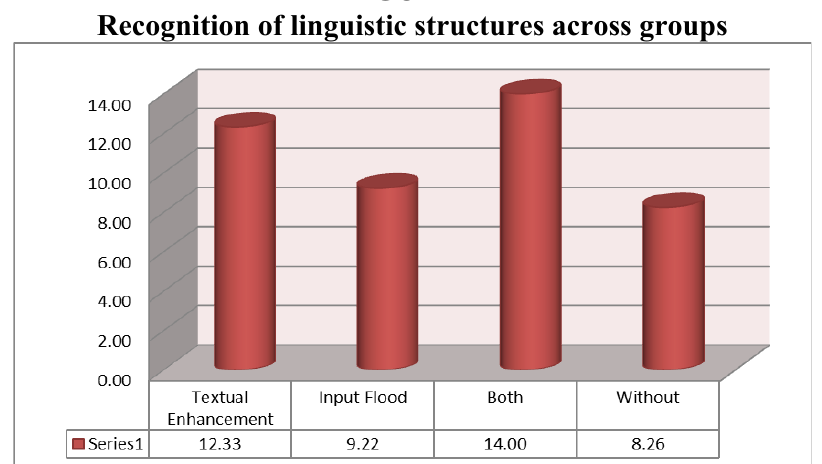
Recognition of linguistic structures across groups